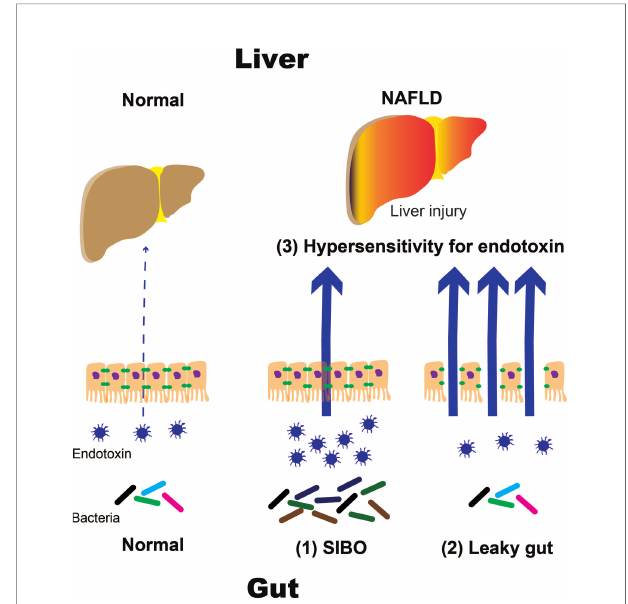
FIGURE 1 | Mechanisms of NAFLD progression caused by intestinal and hepatic factors. NALFD, non-alcoholic fatty liver disease; SIBO, small intestinal bacterial